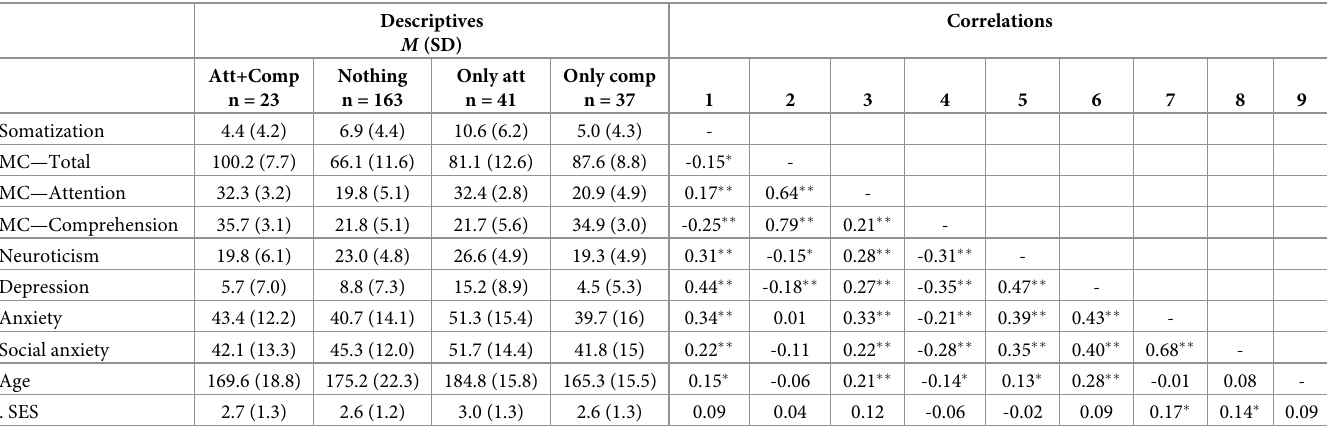
Table 1. Descriptives and